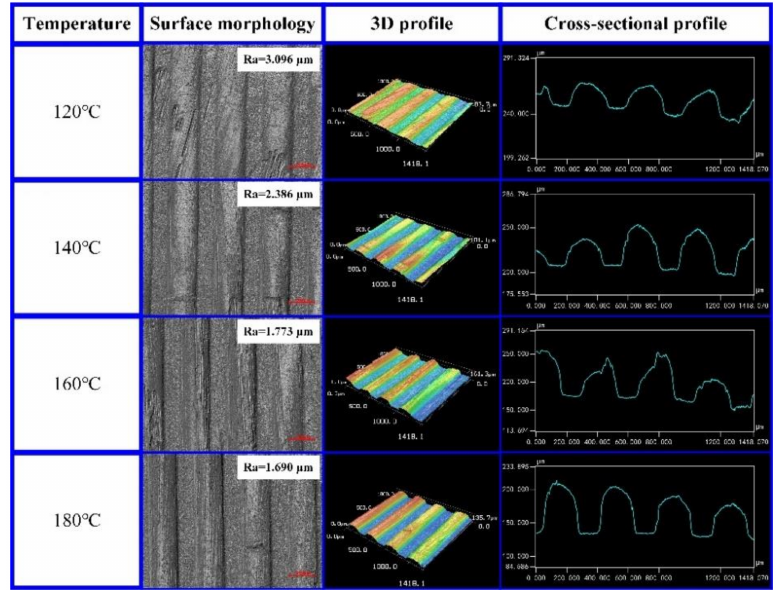
Figure 2. Effect of temperature on the molding quality of the micro-grooves on the CFRP